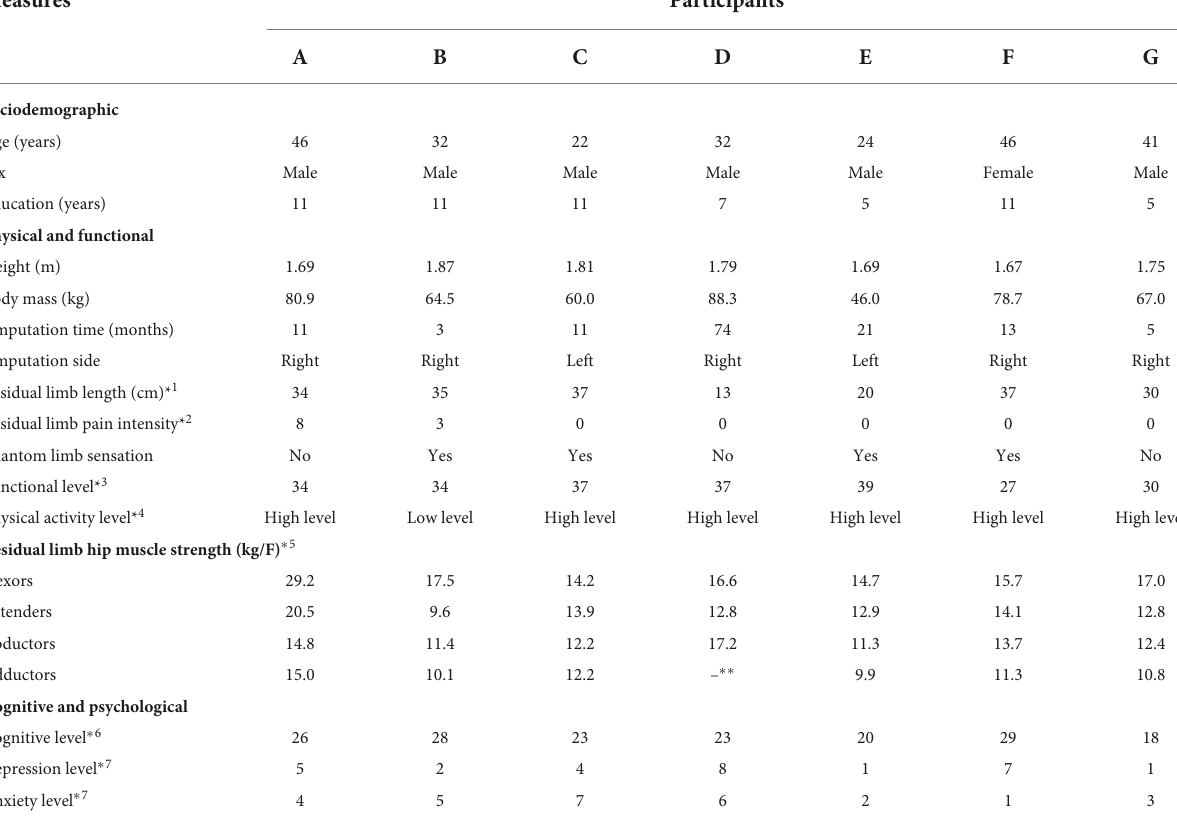
TABLE 1 Characterization of the sociodemographic, physical, functional, cognitive, and psychological aspects of the participants.